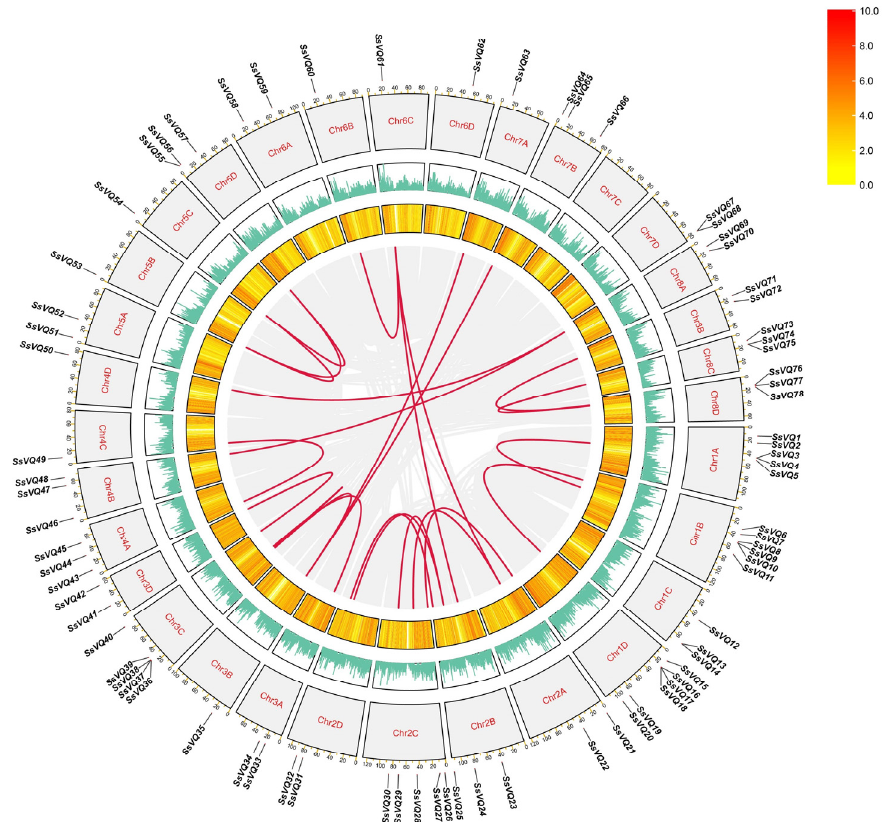
Figure 5. Schematic representations highlighting the interchromosomal relationships of the SsVQ genes. Gray lines indicated all syntenic blocks in the sugarcane genome, and the red lines indicated duplicated VQ gene pairs.